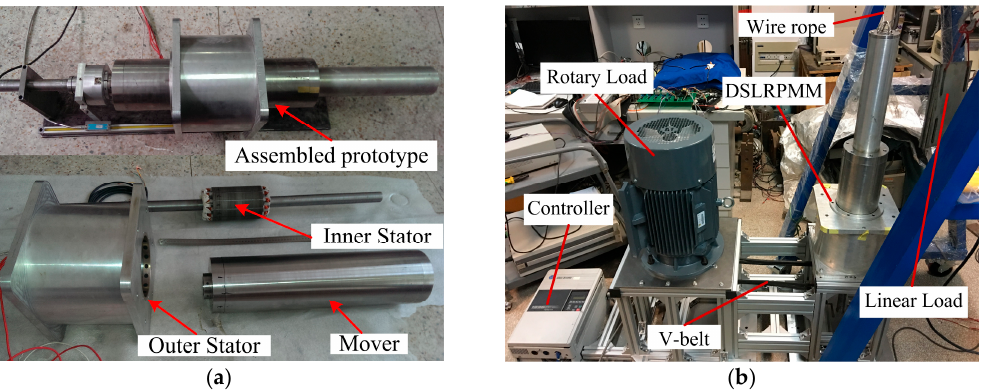
Figure 16. ( a ) Prototype and its components; and ( b ) experimental setup.